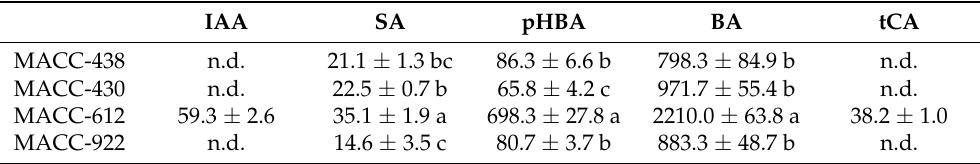
Table 2. Determination of indole ‐ 3 ‐ acetic ‐ acid (IAA), salicylic acid (SA), p ‐ hydroxybenzoic acid (pHBA), benzoic acid (BA), and t ‐ cinnamic acid (tCA) from freeze ‐ dried algae biomass samples us ‐ ing an Acquity I/Class UPLC system ‐ Xevo TQ/XS tandem mass spectrometer. Data represent mean ng g − 1 DW ± SD; n = 3. n.d.: not determined, under the detection limit. Different letters indicate significant differences at p < 0.05. IAA